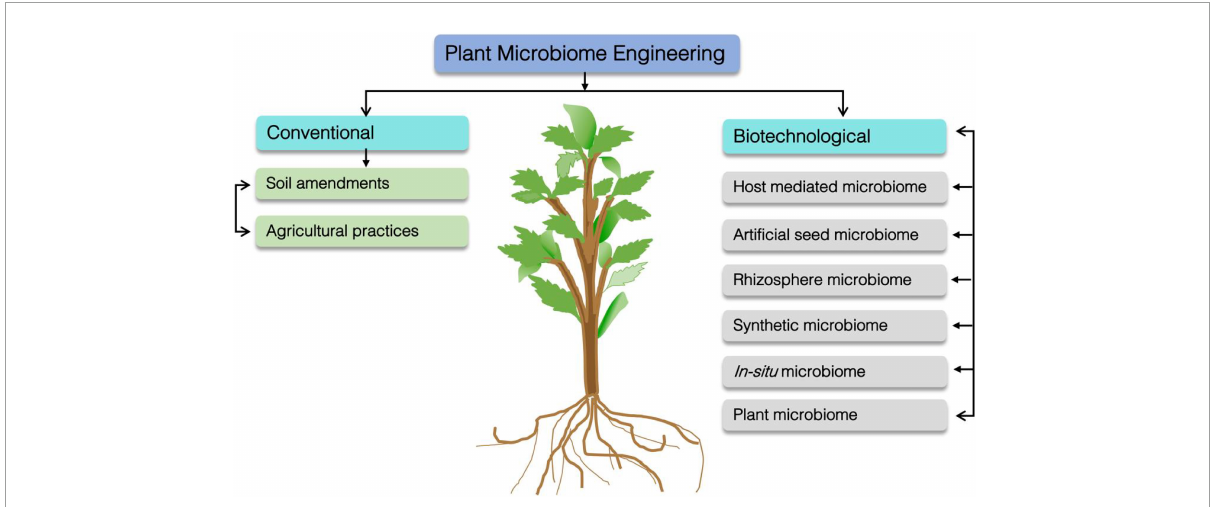
FIGURE2 Plant microbiome engineering via biotechnological and conventional approaches. Host-mediated microbiome (indirectly selection of microbiome through utilization of host phenotype), artificial seed microbiome (artificial selection of microbiome and its integration/inoculation with seeds. This establish microbiome may evolve during the development and germination that consequently impact plant microbiome structure and function), Rhizosphere microbiome (bacterial competitiveness engineering) Synthetic microbiome ( genetically engineered microbes inoculation to host plant) In situ microbiome (manipulation of native microbial community in their native context) Plant mycobiome (optimization and improvement of beneficial plant–fungal